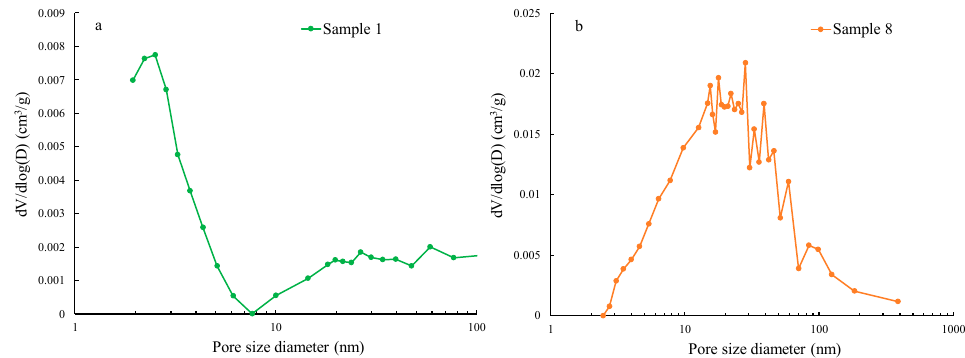
Figure 5. The pore size distributions of the samples 1 and 8. ( a ) Sample 1 of the Upper/Lower Bakken; ( b ) Sample 8 of the Middle Bakken.